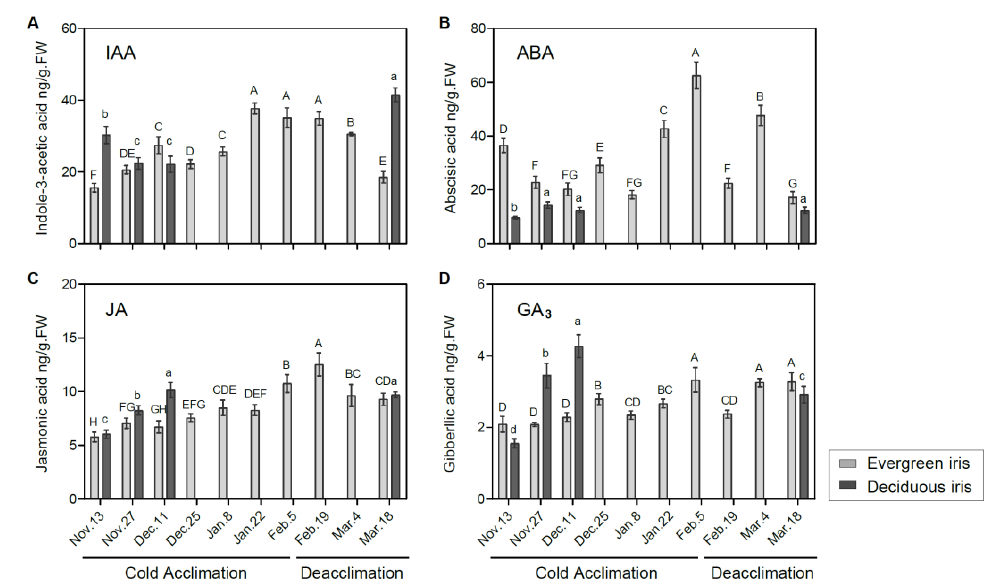
Figure 4. Measurements of endogenous phytohormones in the functional leaves of evergreen and deciduous irises under natural cold acclimation and deacclimation. Levels of ( A ) IAA, ( B ) ABA, ( C ) JA and ( D ) GA 3 . Cold acclimation process, sampling from 13 November to 5 February 2021; deacclimation process, sampling from 19 February to 18 March 2021. Values are the means of three biological replicates, and bars represent the standard error. Different letters indicate significant differences according to Duncan’s multiple range test at p < 0.05. Capital and lowercase letters represent significant differences for relevant parameters within evergreen and deciduous irises ( p < 0.05), respectively.